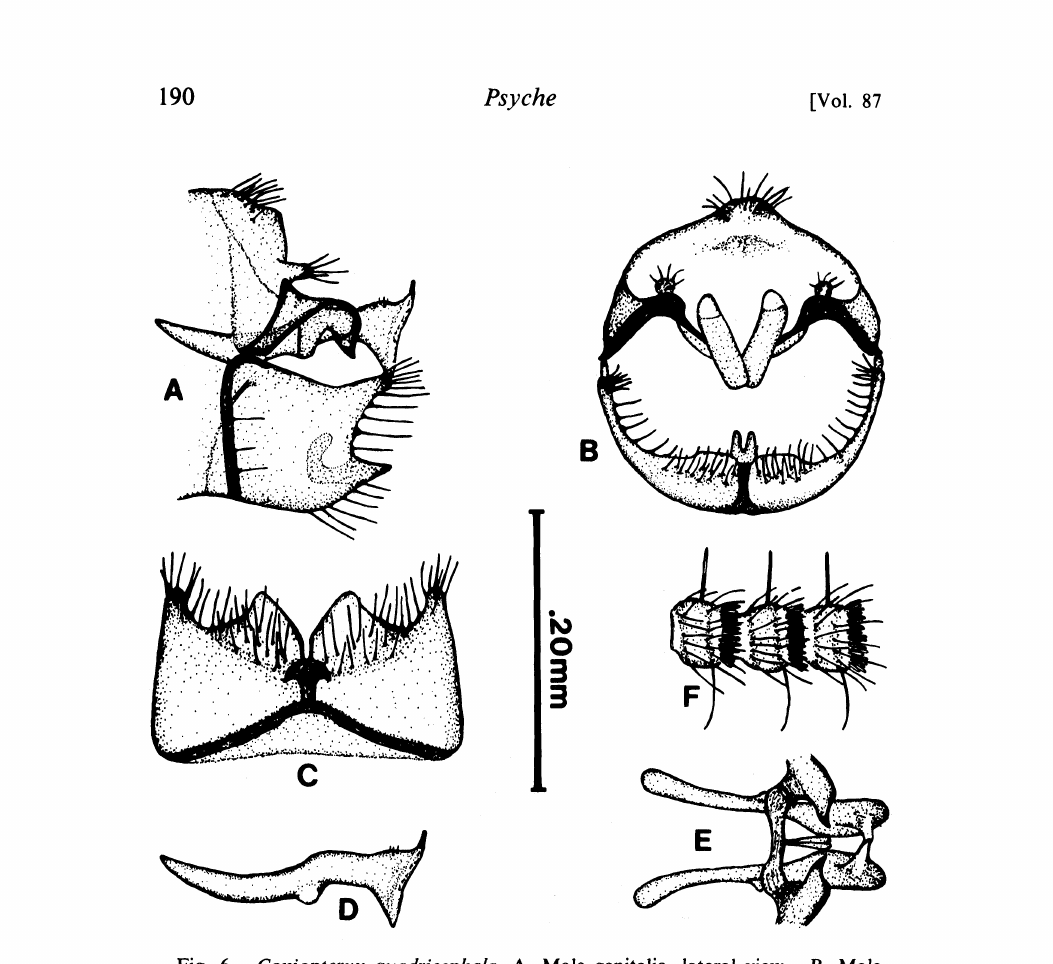
Fig. 6. Coniopteryx quadricephala. A. Male genitalia, lateral view. B. Male genitalia, caudal view. C. Hypandrium, ventralview. D. Paramere, lateralview. E. Male internal genitalia, ventral view. F. Male antennal segments